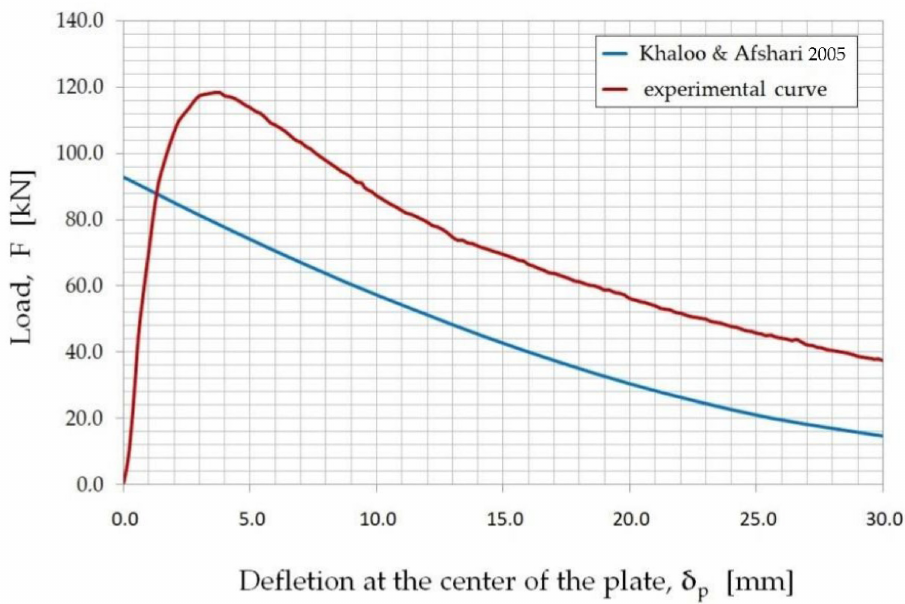
Figure 9. The load–deflection relation (F– δ p,exp ) for the fiber composite covered by the research: the theoretical curve, according to Khaloo, A.R.; Afshari (2005) [64], and the experimental curve. Based on the obtained test results, the energy absorption capacity of the plates (E pexp ) of the tested fiber composite was determined. The PN-EN 14488-5 standard [35] defines this as the area under the load–deflection curve (F– δ p ) between the deflection values ( δ p ), respectively: 0 and 25 mm. The results obtained for all plates are presented in Table